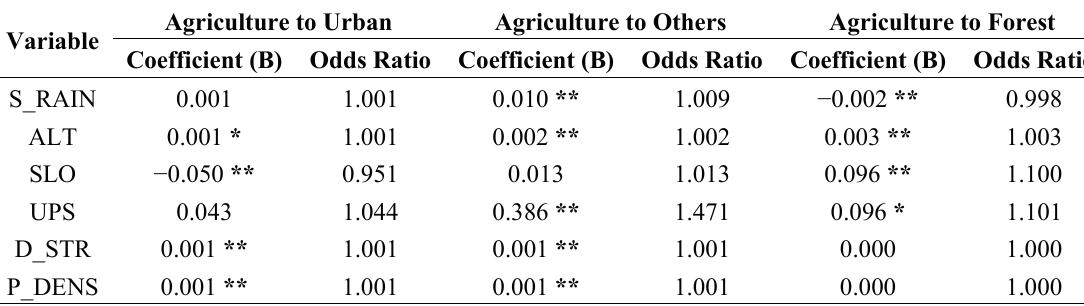
Table 7. Factors of agricultural land-use changes using logistic regression